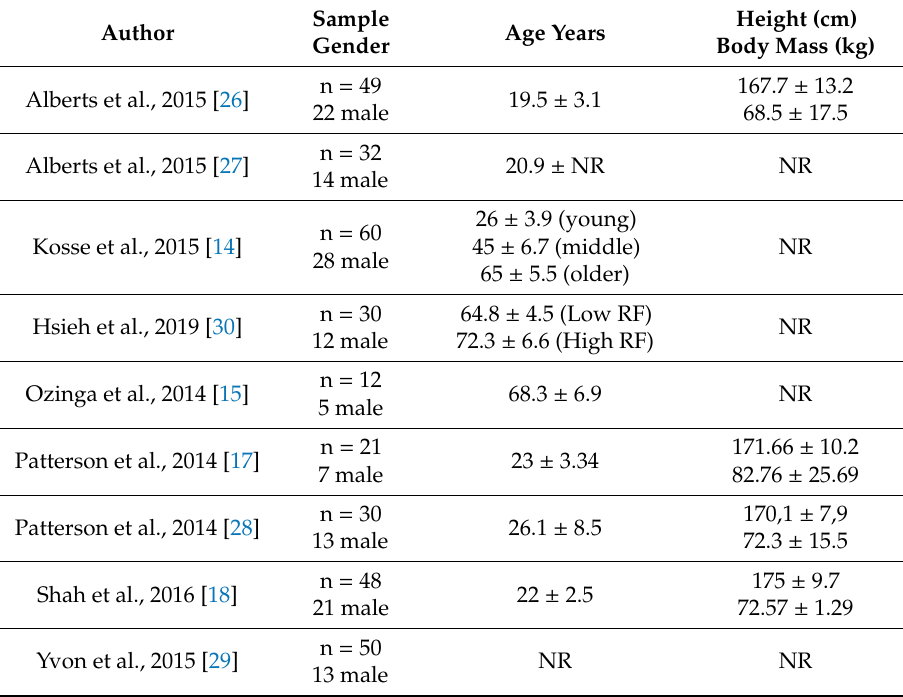
Table 1. Sample demographic characteristics (mean ± standard